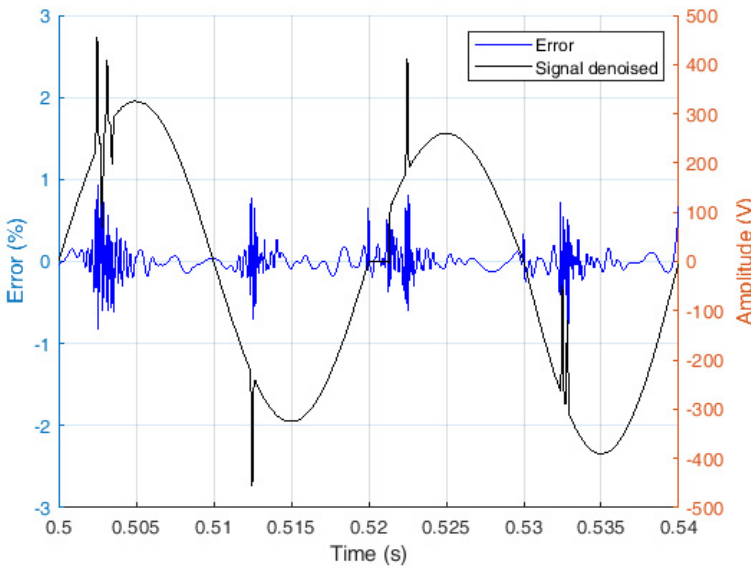
Figure 11. Percentage error of denoised signal and denoised signal.